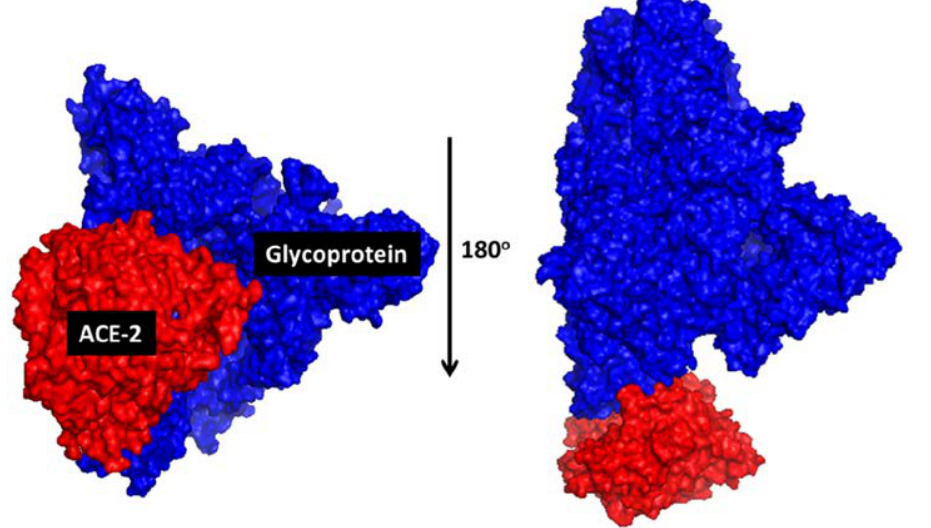
Fig. 2. Molecular visualization of the ACE2 (red) molecular complex and SARS-CoV-2 spike glycoprotein (blue). Both are displayed in a rigid surface structure with specific colour